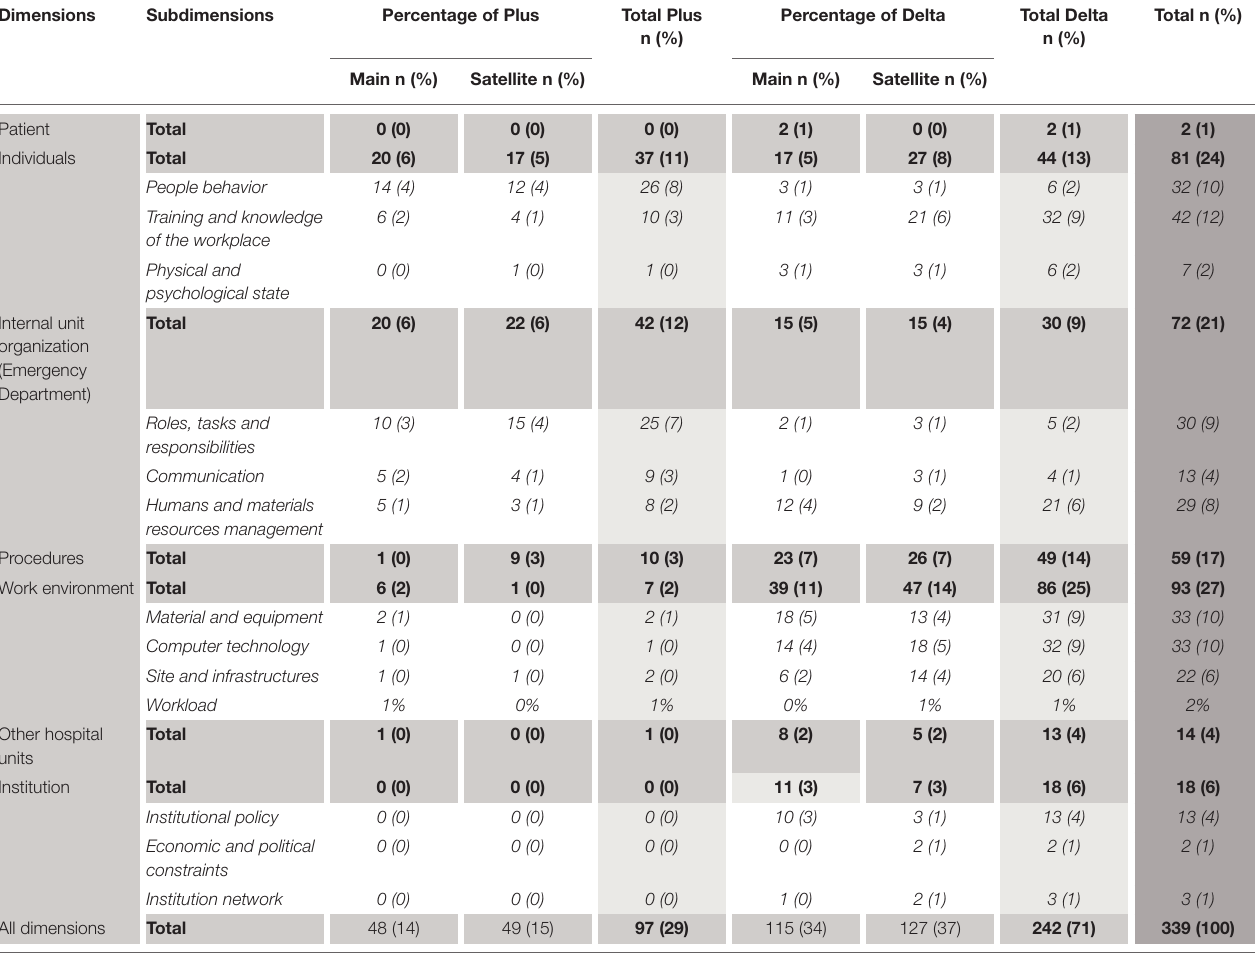
TABLE 2 | Percentages of Plus and Delta based on the “Debriefing and Organizational Lessons Learned (DOLL)” framework dimensions.